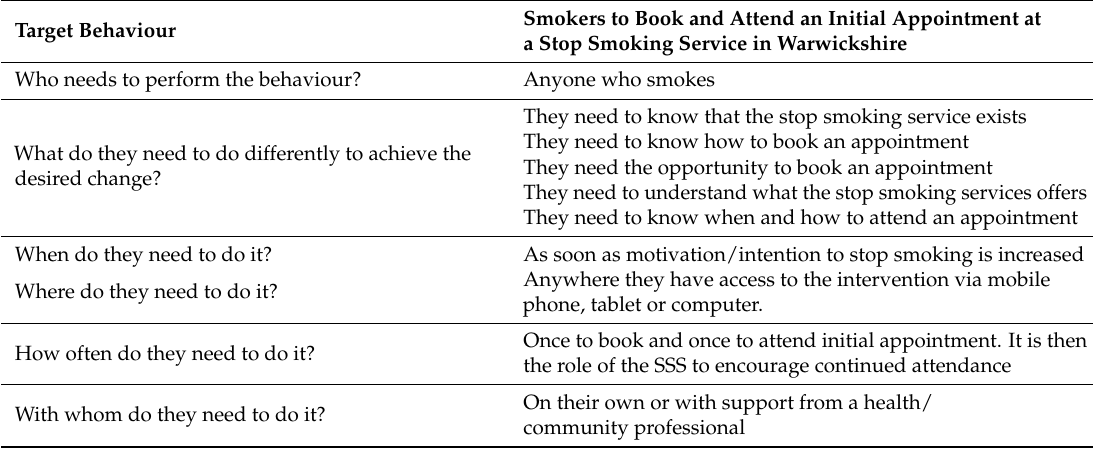
Table 1. Specifying the target behaviour and